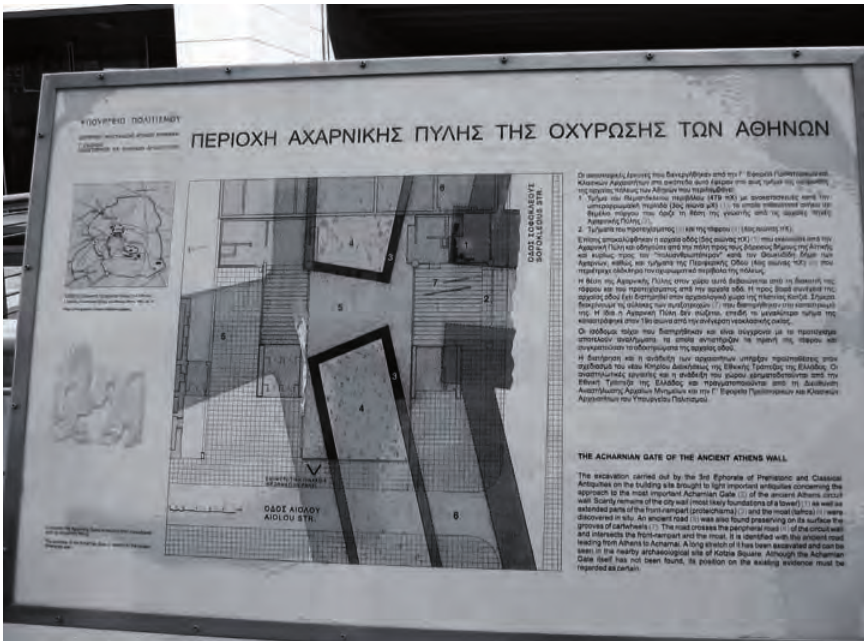
Figure 7. Informative panel, National Bank of Greece (Photo by K.